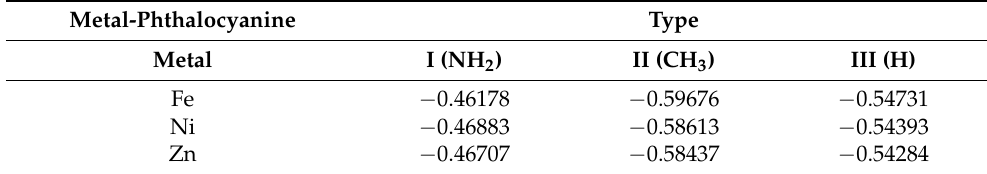
Table 1. HOMO orbital energies (a.u.) (HF/LanL2DZ level of theory).